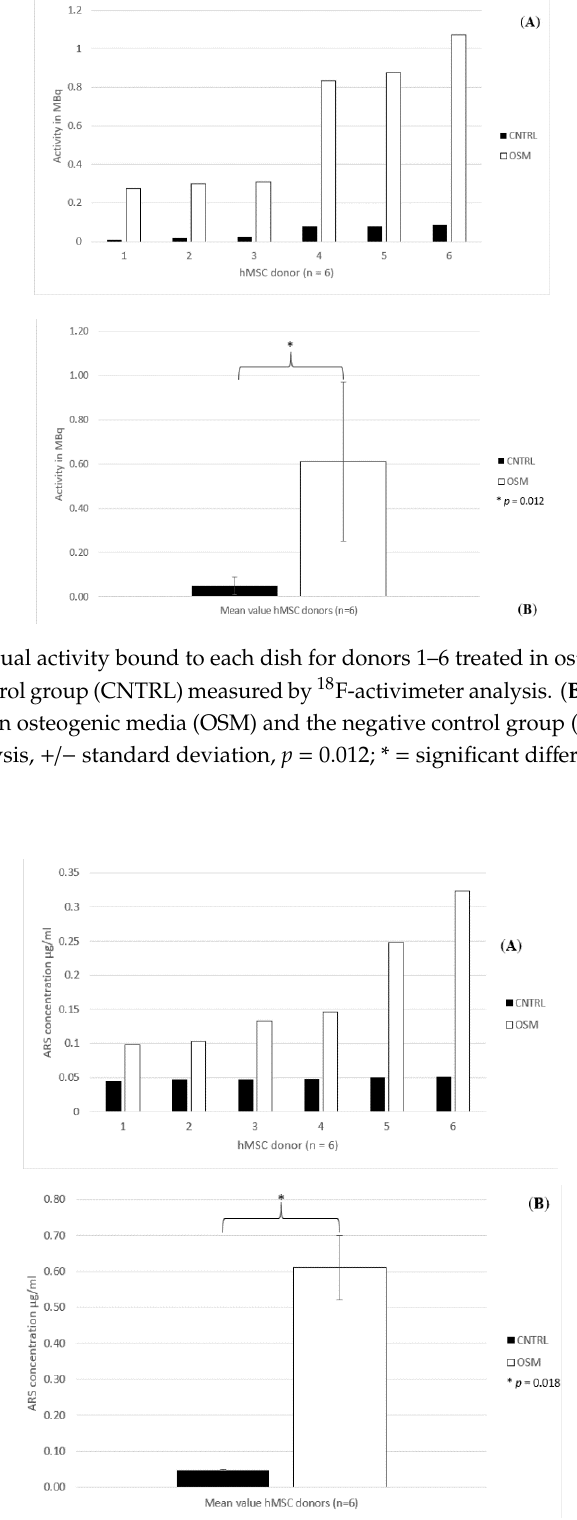
Figure 5. ( A ) Individual Alizarin Red stain (ARS) concentration in µg/mL for each dish, donors 1–6 treated in osteogenic media (OSM) and the negative control group (CNTRL). ( B ) Mean Alizarin Red stain concentration in µg/mL for the osteogenic media (OSM) and negative control group (CNTRL), +/ − standard deviation, p = 0.018; * = significant difference between the two groups, p ≤ 0.05.